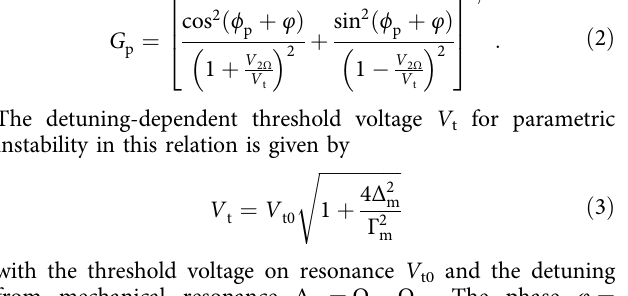
phase ϕ p , we fi nd an oscillatory behavior between amplitude ampli fi cation and de-ampli fi cation with a periodicity of Δ ϕ p = π (cf. Fig. 2b). To explore the dependence of the ampli fi cation on the parametric modulation amplitude V 2 Ω , we repeat this experiment for different voltages V 2 Ω and extract maximum and minimum gain by fi tting the data with Eq. (2) for V t = V t0 and φ = 0. The extracted values follow closely the theoretical curves up to a voltage V 2 Ω ≈ 0.9 V t0 , above which we are limited by resonance frequency fl uctuations of the mechanical